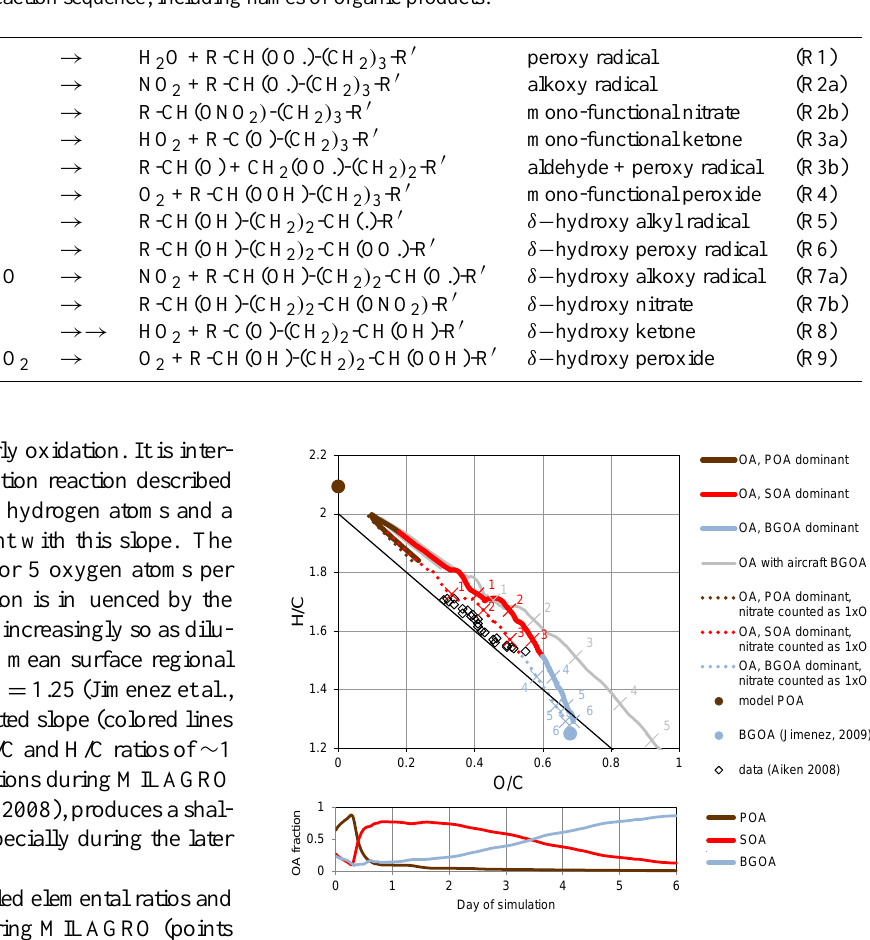
Table 4. Example hydrogen migration reaction sequence, including names of organic products.